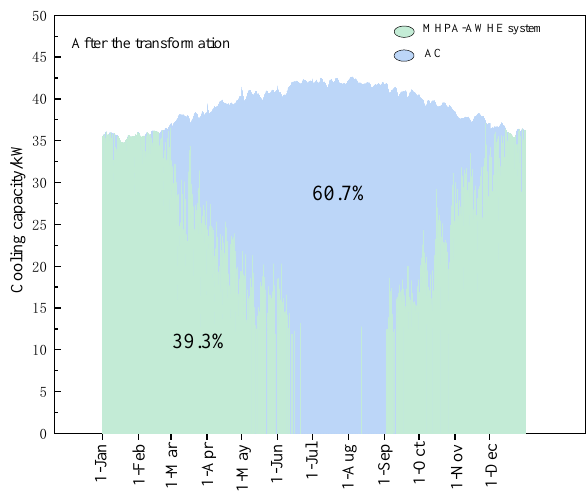
Figure 26. Annual hourly energy efficiency ratio (EER) of DCs before and after the transformation.